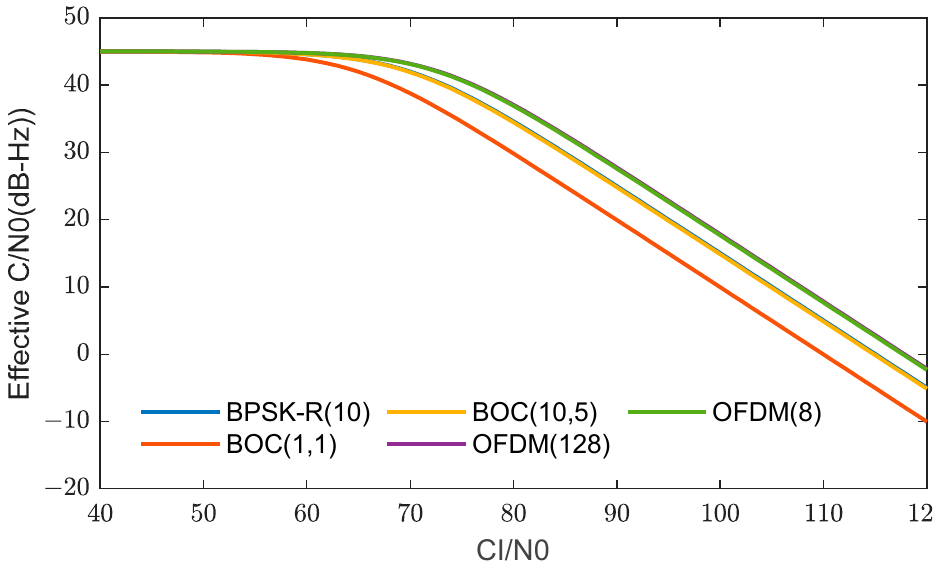
Figure 13. The equivalent carrier-to-noise ratio.